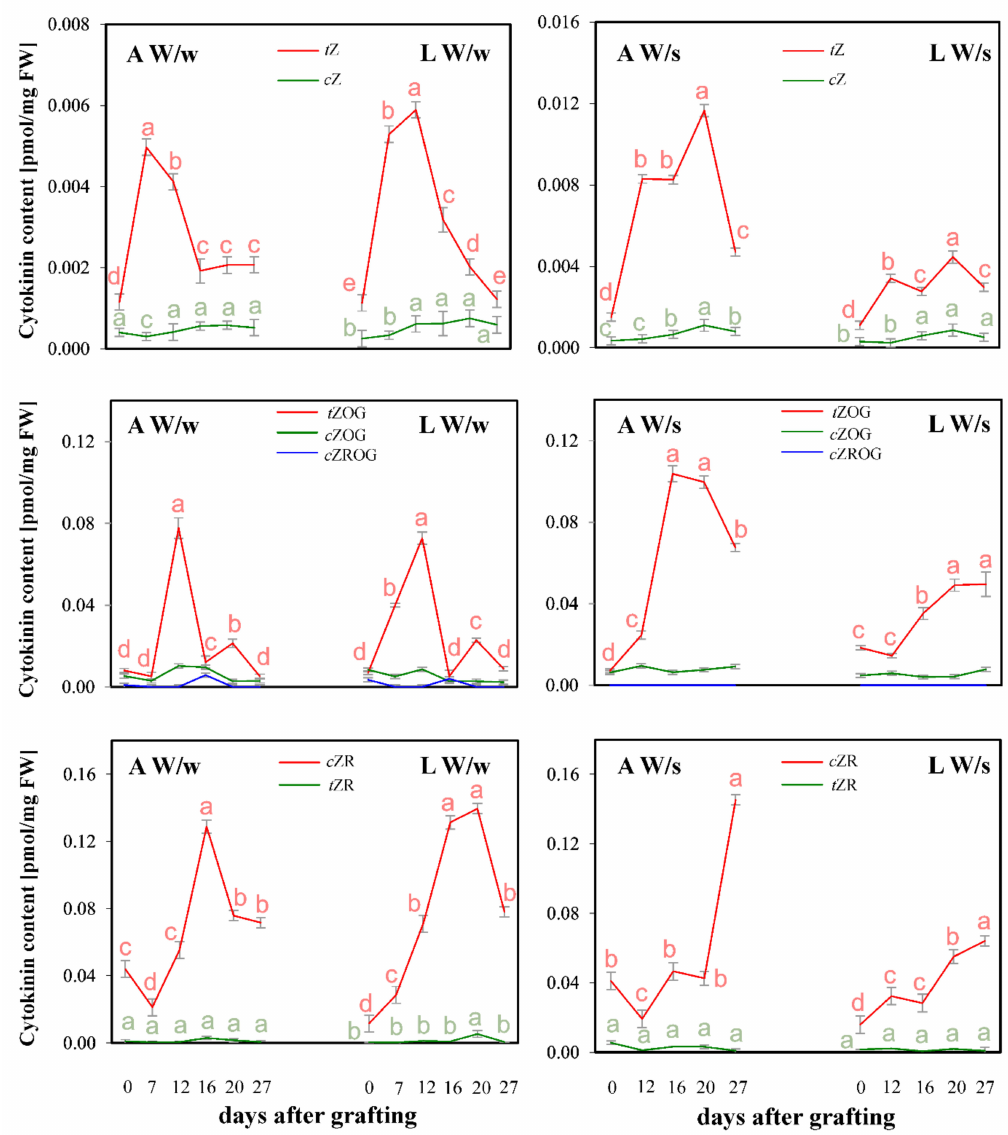
Figure 2. Content (pmol / mg FW) of cis ( c ) and trans ( t ) zeatin (Z), zeatin O -glucoside (ZOG), zeatin riboside O -glucoside (ZROG) and zeatin riboside (ZR) in apices (A) and the youngest leaves (L) of the upper part of winter rapeseed plants after 0, 7, 12, 16, 20 and 27 days after grafting on winter, flowering plants (W / w) and after 0, 12, 16, 20 and 27 days after grafting on spring flowering plants (W / s). Significant di ff erences ( p ≤ 0.05) are marked as di ff erent letters according to Duncan’s